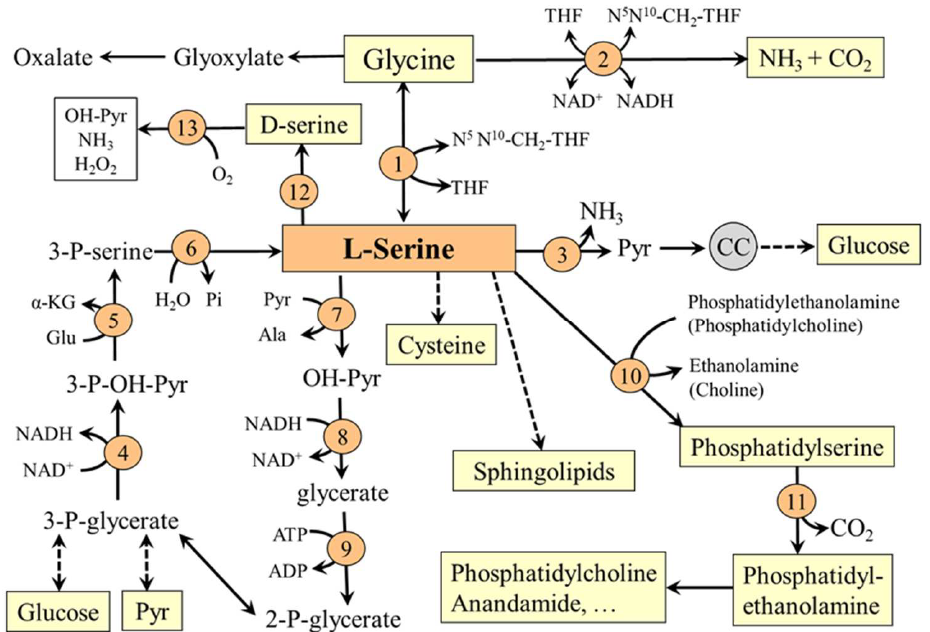
Figure 4. Pathways of serine synthesis and metabolism. 1, serine hydroxymethyltransferase; 2, glycine cleavage system; 3, serine dehydratase; 4, 3-phosphoglycerate dehydrogenase; 5, phosphoserine aminotrasferase; 6, phosphoserine phosphatase; 7, serine-pyruvate aminotransferase; 8, glycerate dehydrogenase; 9, glycerate kinase; 10, phosphatidylserine synthase; 11, phosphatidylserine decarboxylase; 12, racemase; 13, D-amino acid oxidase. CC, citric cycle; Pyr, pyruvate.